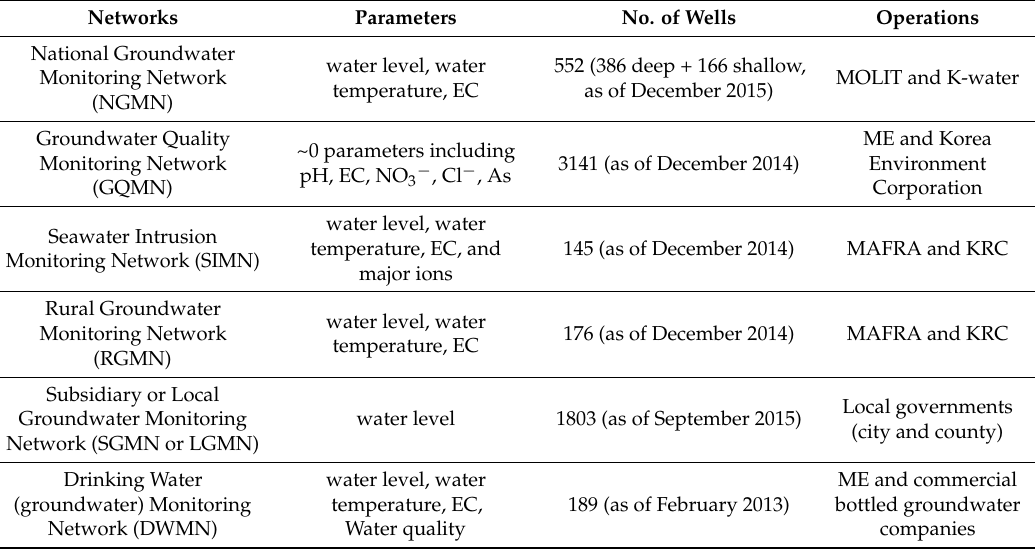
Table 2. Groundwater monitoring networks in